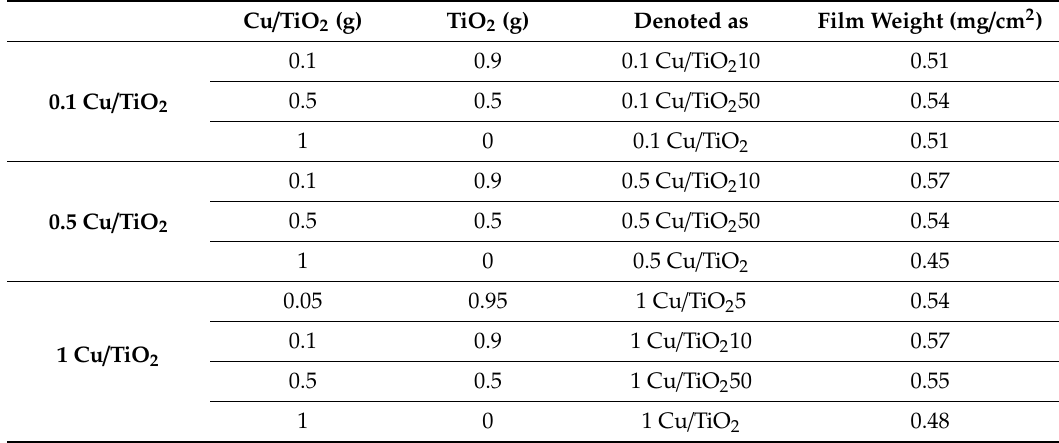
Table 3. Film composition at various weight ratios of Cu / TiO 2 :TiO 2